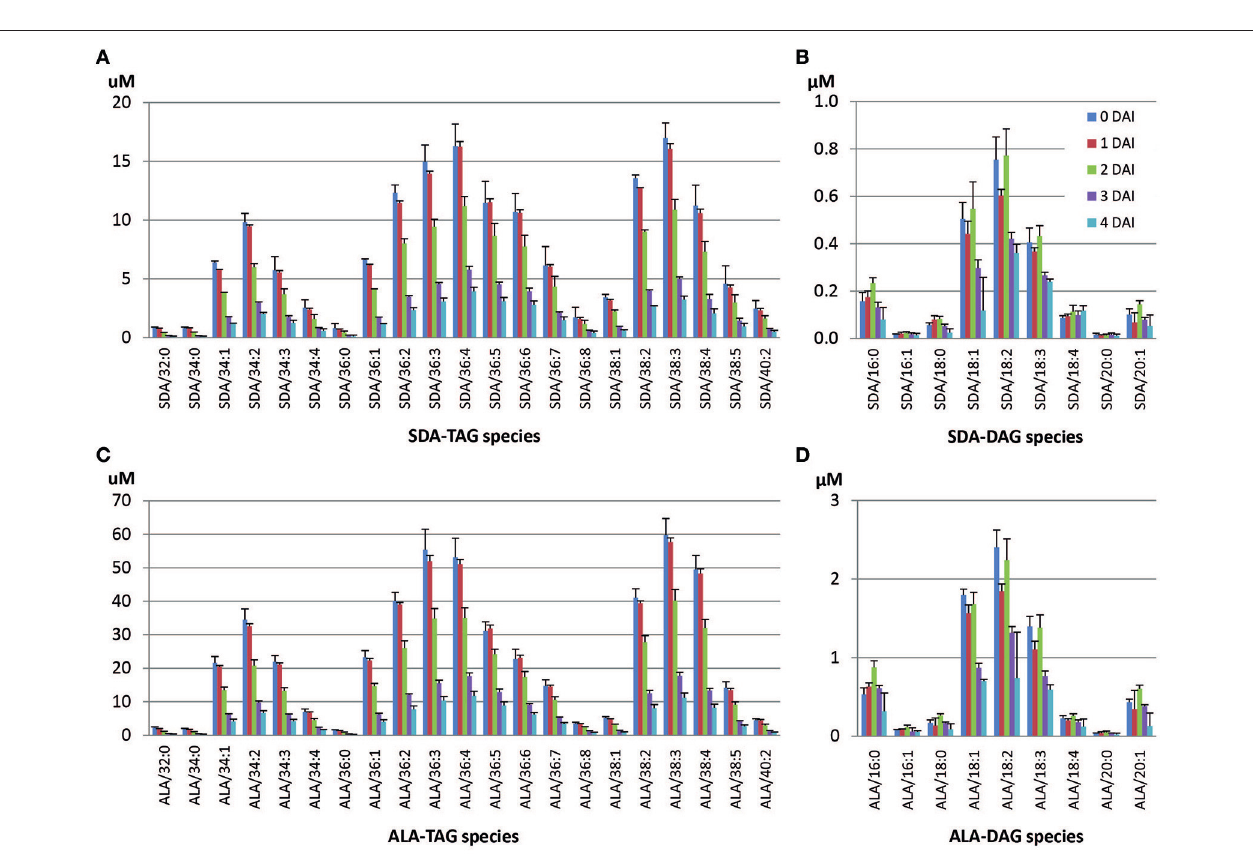
There was a trend toward higher mobilization of TAG species that contained shorter chain, saturated (or not highly unsaturated) fatty acids. Conversely, TAG species containing longer chains and higher levels of unsaturation were mobilized